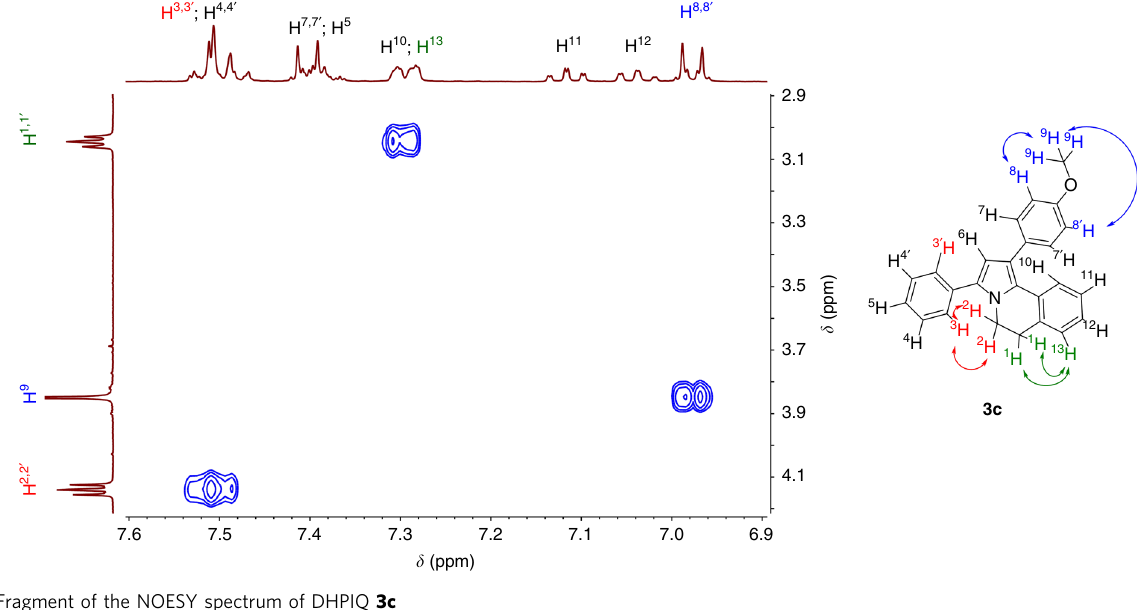
Fig. 4 Fragment of the NOESY spectrum of DHPIQ 3c